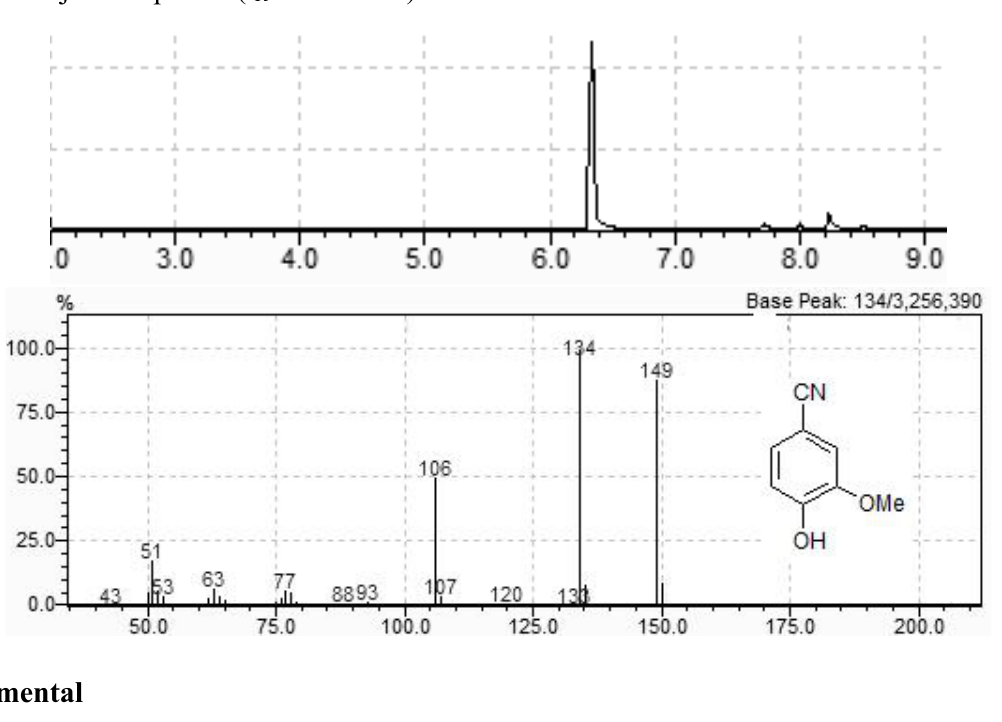
Figure 2. GC chromatogram of scaled up conversion of vanillin into vanillonitrile and MS = 6.33 of the major compound (t R